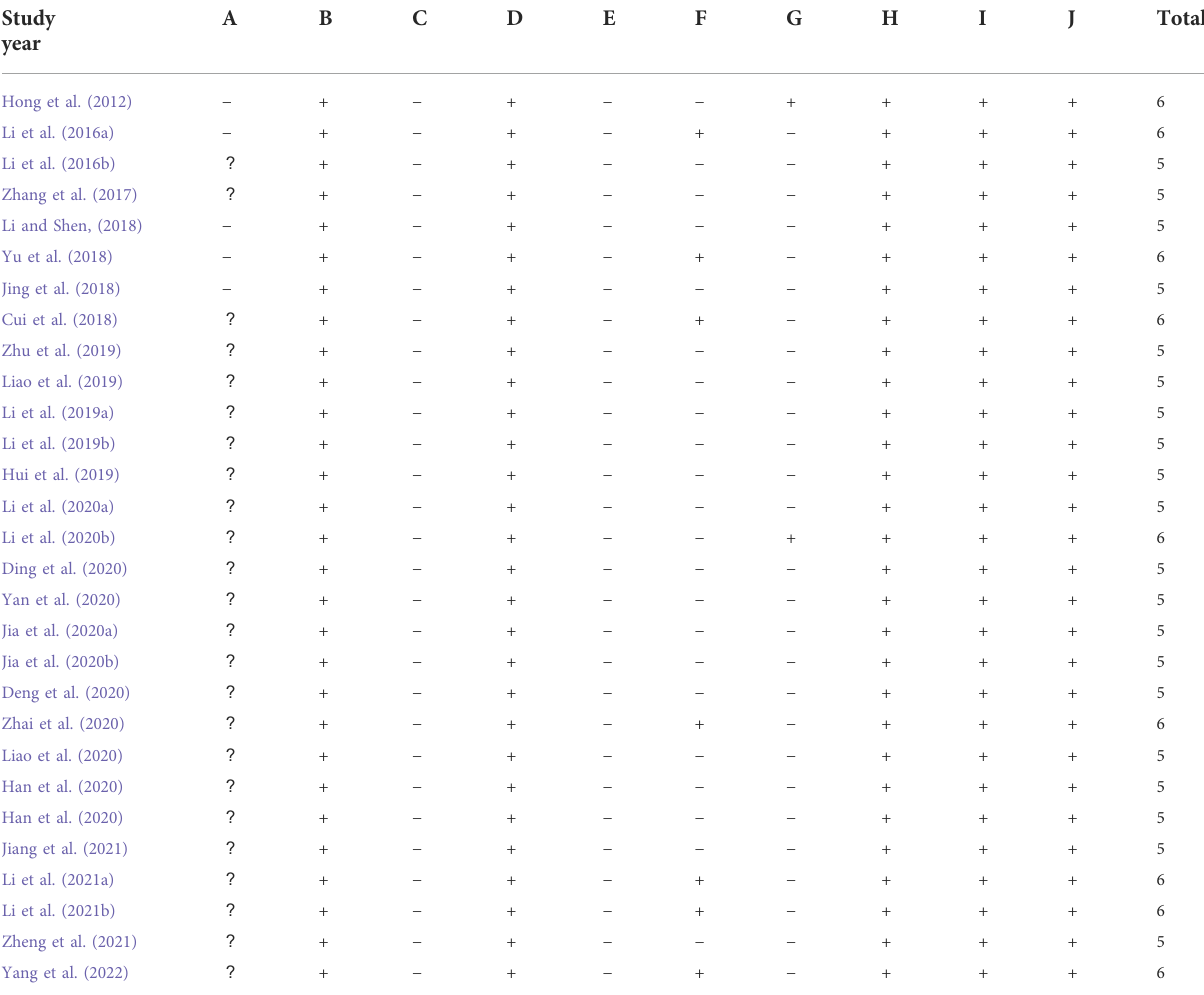
TABLE 3 The methodological quality of included